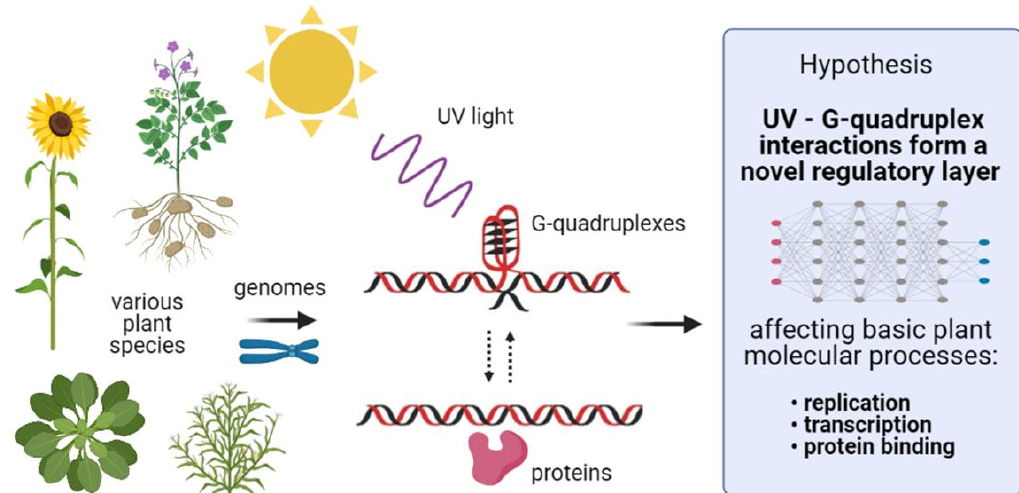
Figure 4. Schematic of UV interacting with G4s. Solar UV radiation penetrates the cell wall, cytoplasmic membrane, and nuclear membrane, and it can directly interact with genomic DNA. We hypothesize that G4s are exceptionally sensitive to UV due to their central metallic K + stabilizing ions and Hoogsteen base pairs forming stacked G4 tetrads. Generally, we propose that the interaction of G4s with UV leads to partial destabilization of the G4 structure and, thus, allows relatively rapid and finely tuned changes of molecular process rates, which affects signaling pathways and plant responses to UV irradiation.